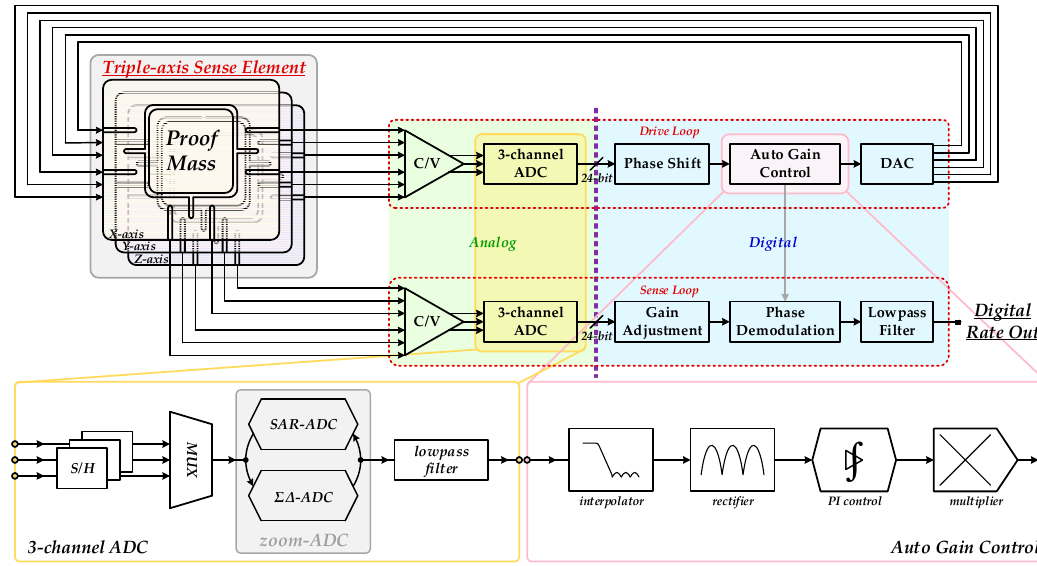
Figure 3. Systematic design of the proposed interface ASIC for MEMS gyroscopes.